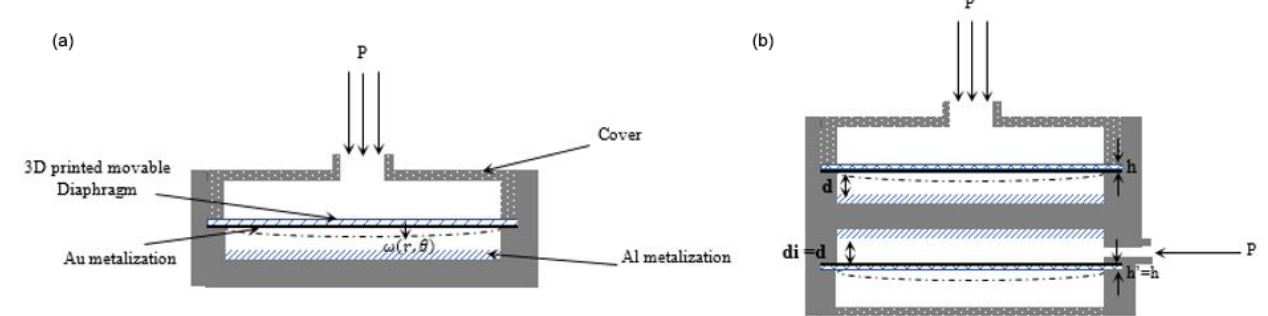
Figure 1. Design of the structures of the two studied pressure sensors. (a) Structure A: sensor with C 0 fixed. (b) Structure B: sensor with C 0 variable.